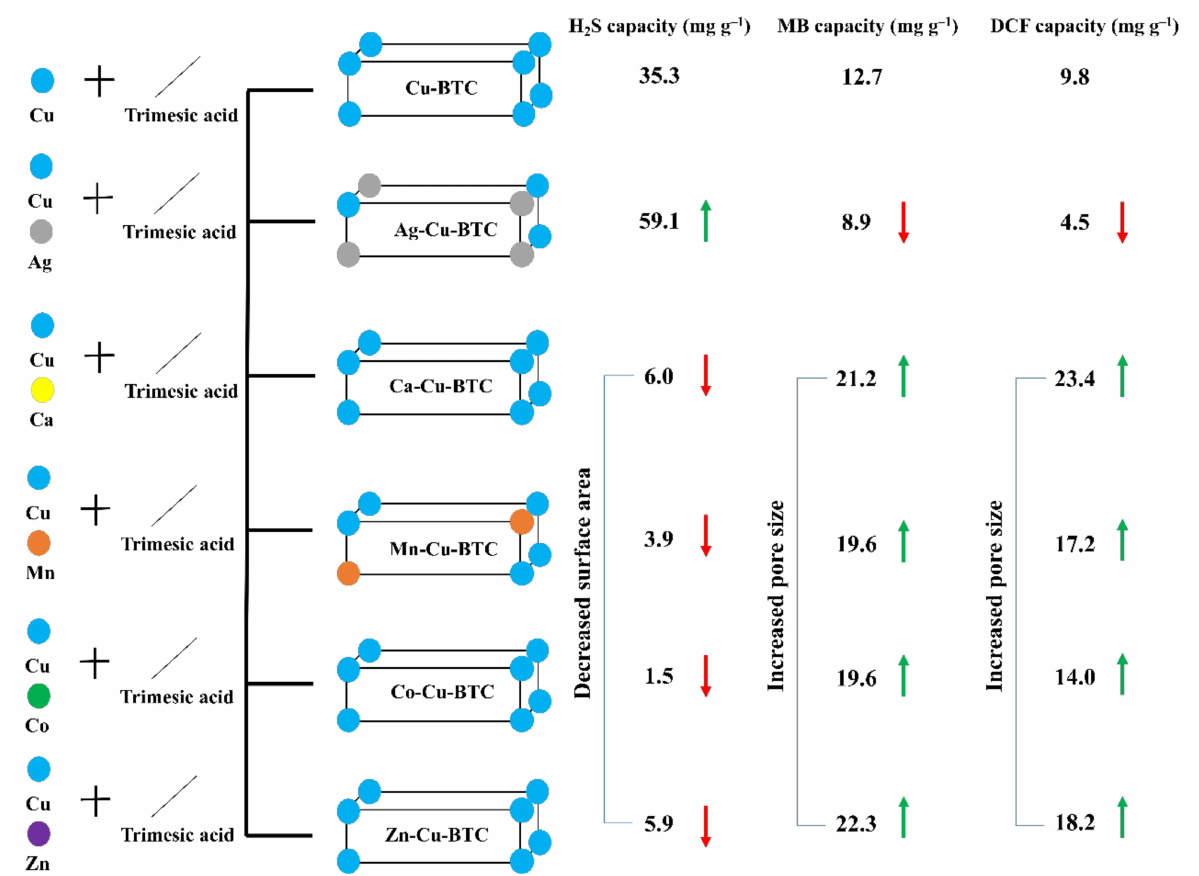
Figure 6. Summary of the present work.